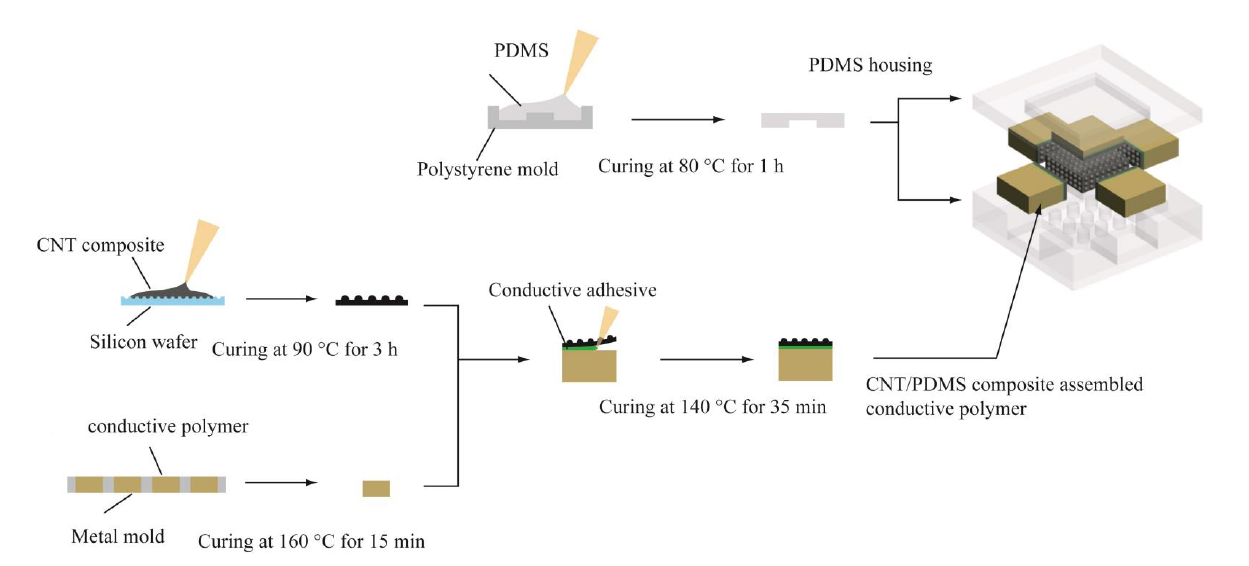
Figure 2. Fabrication process flow of the proposed sensor: CNT/PDMS composite film is fabricated on micromachined silicon wafer to have microdome structures and attached on a conductive polymer block with conductive adhesive. The conductive polymer blocks with CNT/PDMS composite films attached are integrated together in PDMS housings to constitute a multidirectional force sensing tactile